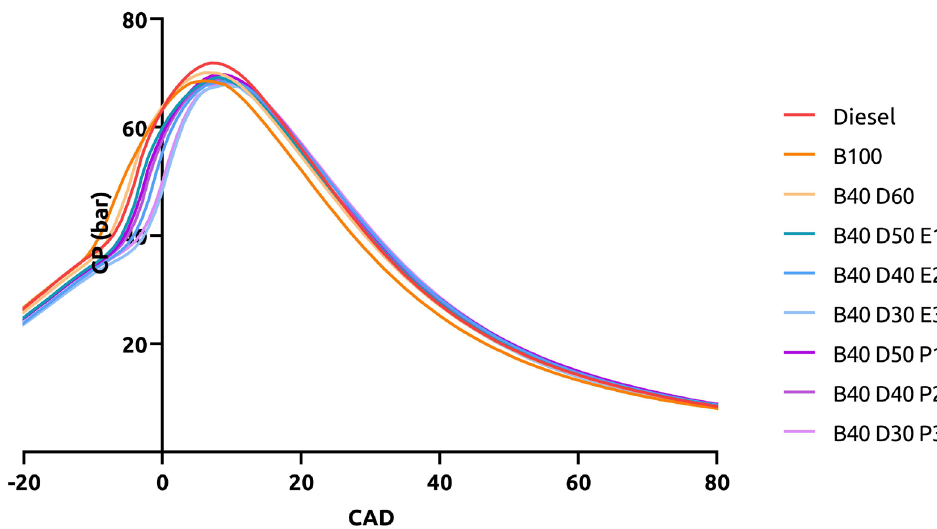
Figure 5. In-cylinder pressure for tested fuels at full engine load.